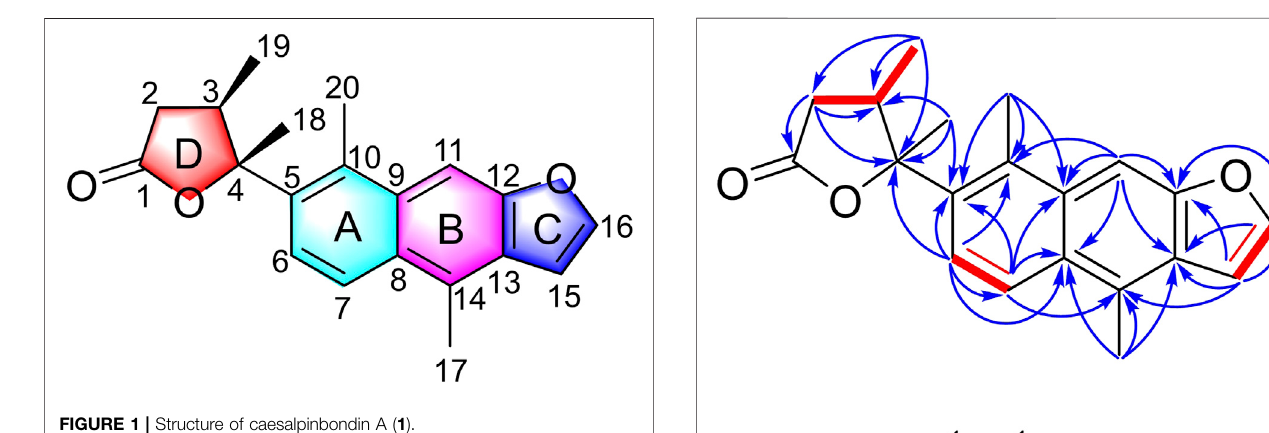
FIGURE 1 | Structure of caesalpinbondin A ( 1 ).